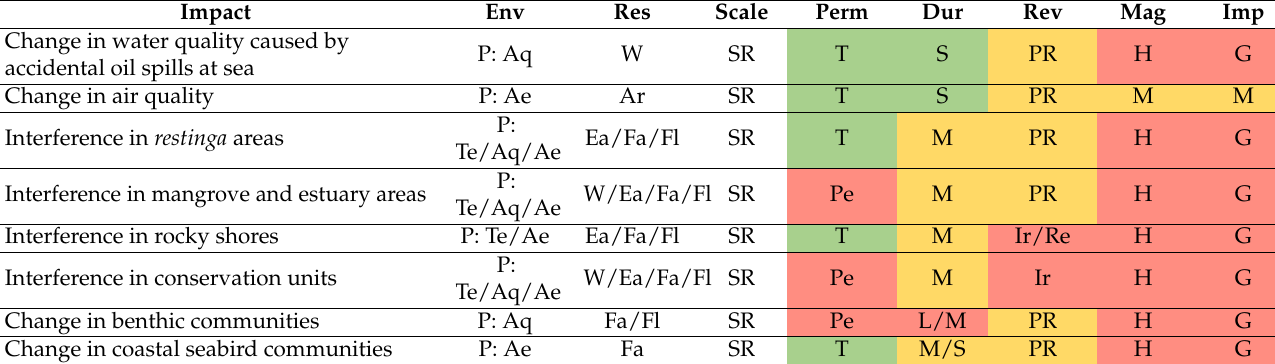
Table 9. Potential impacts during Stage